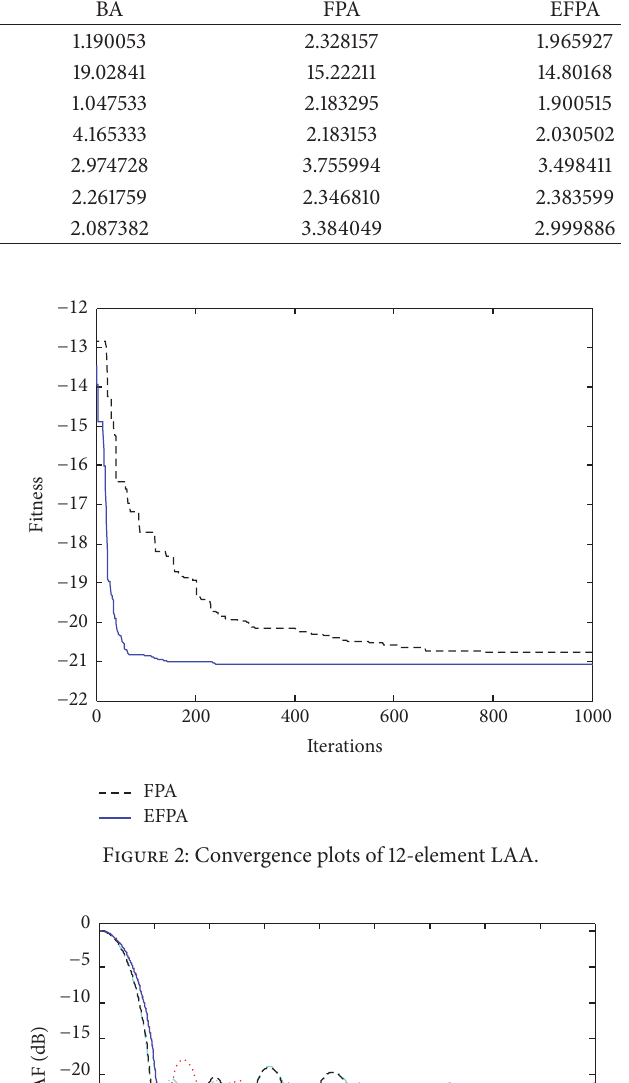
Table 5: Time-complexity comparison for various algorithms (time taken by each algorithm for single run in seconds). Function